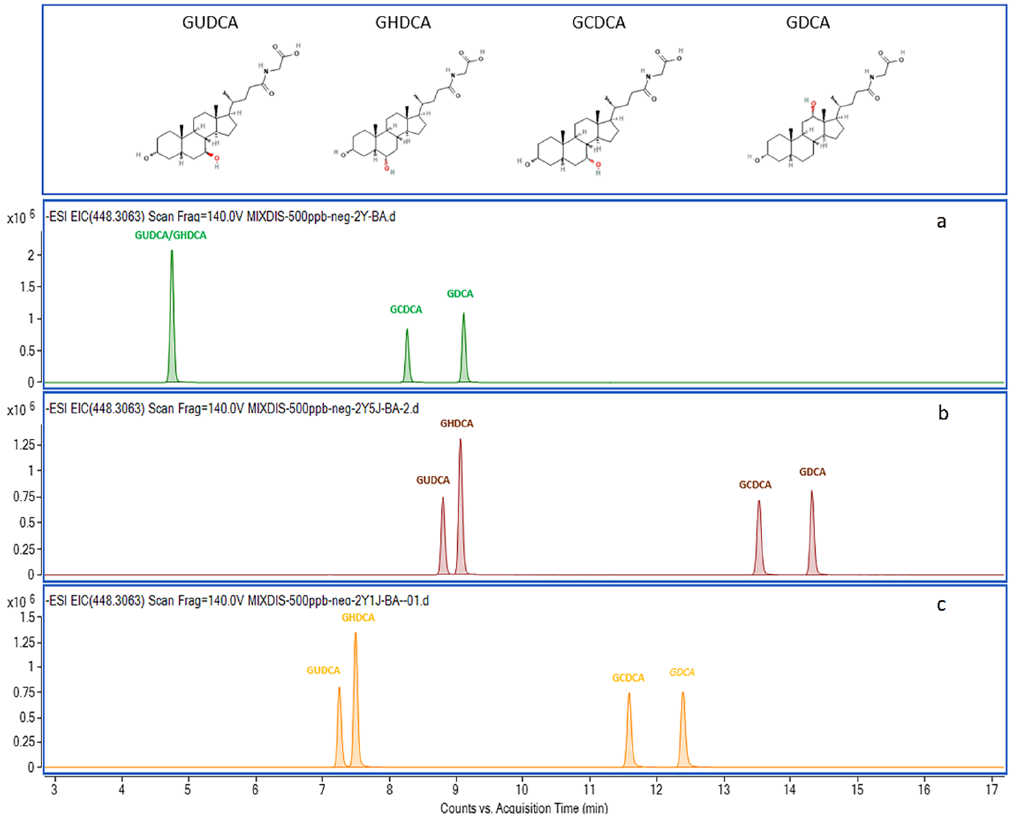
Figure 2. Mobile phase optimization for isobaric compounds chromatography separation. The GUDCA, GHDCA, GCDCA, and GDCA have the same molecular formula, C 26 H 43 NO 5 ([M-H]- m / z 448.3063), but different -OH positions. ( a ) 2 mM ammonium acetate in aqueous solvent; ( b ) 2mM ammonium acetate and 0.05% formic acid in aqueous solvent; ( c ) 2 mM ammonium acetate and 0.01% formic acid in aqueous solvent.